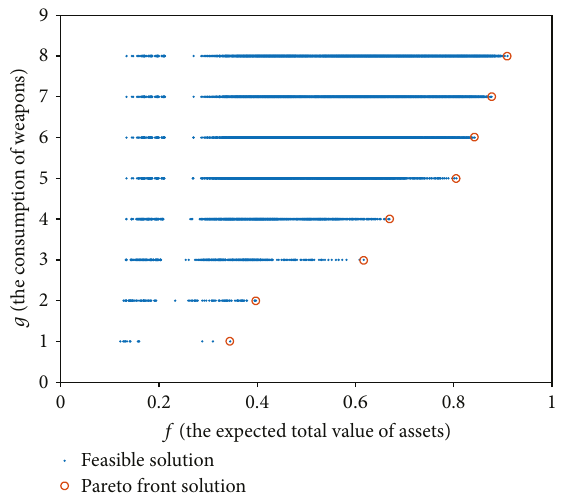
Figure 2: Illustration of the asset-based SWTA